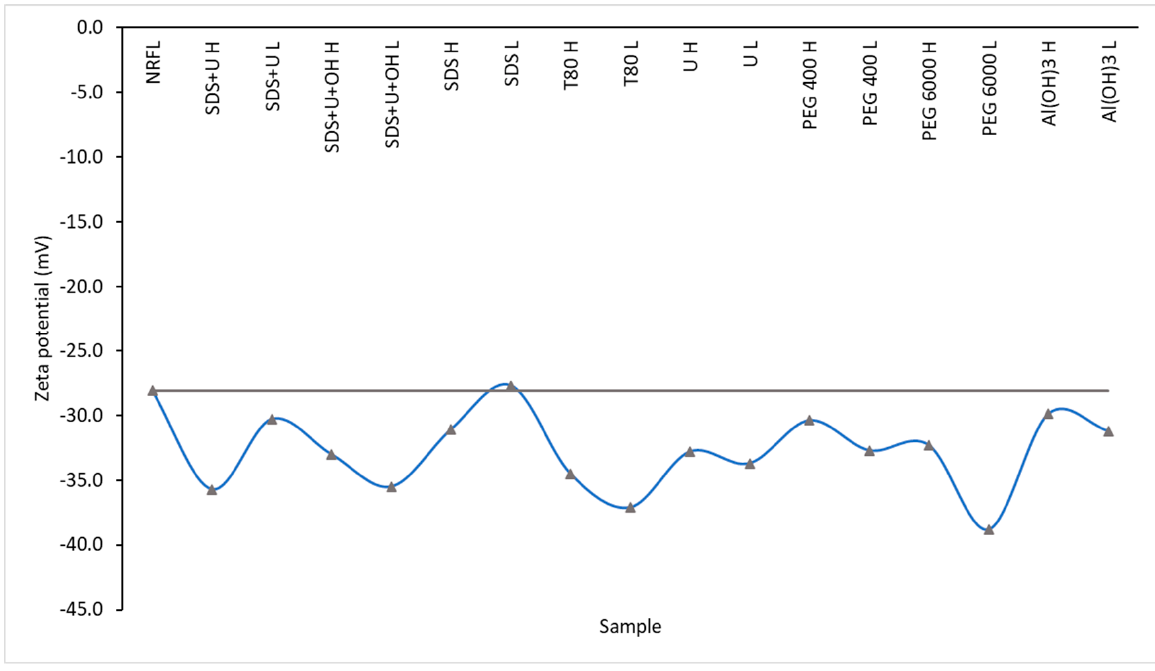
Figure 7. Zeta potentials of deproteinized systems.